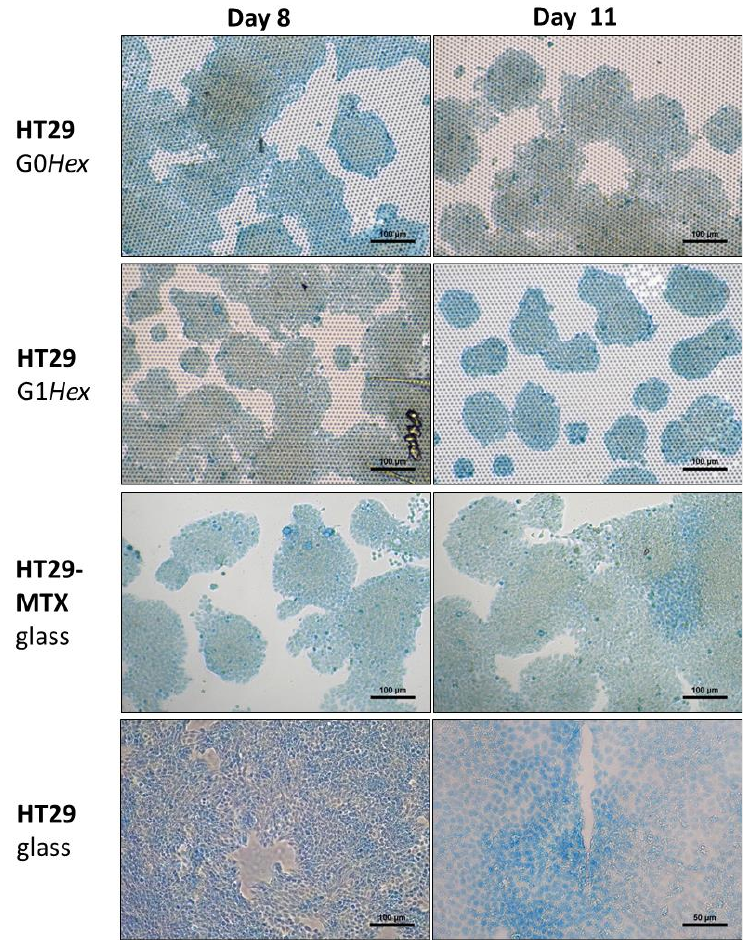
Figure 2. Alcian blue staining of mucus released by HT29 cells, as well as MTX-differentiated HT29 cells on glass and topographic surfaces (G0 Hex , G1 Hex ). Scale bars: 100 μ m, except for HT29 (11 days, glass), where scale bar: 50 μ m. Number of independent experiments: n = 4.